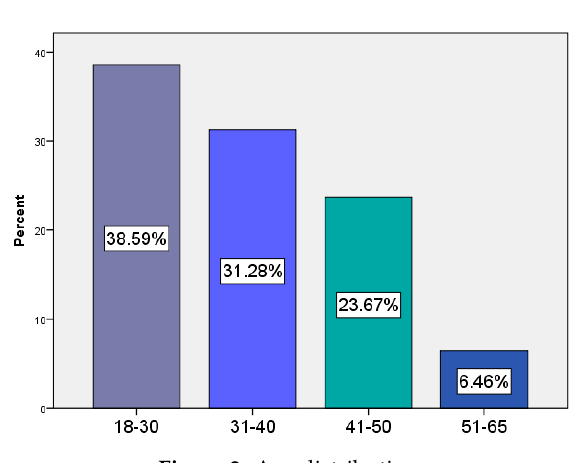
Figure 3. Age distribution.